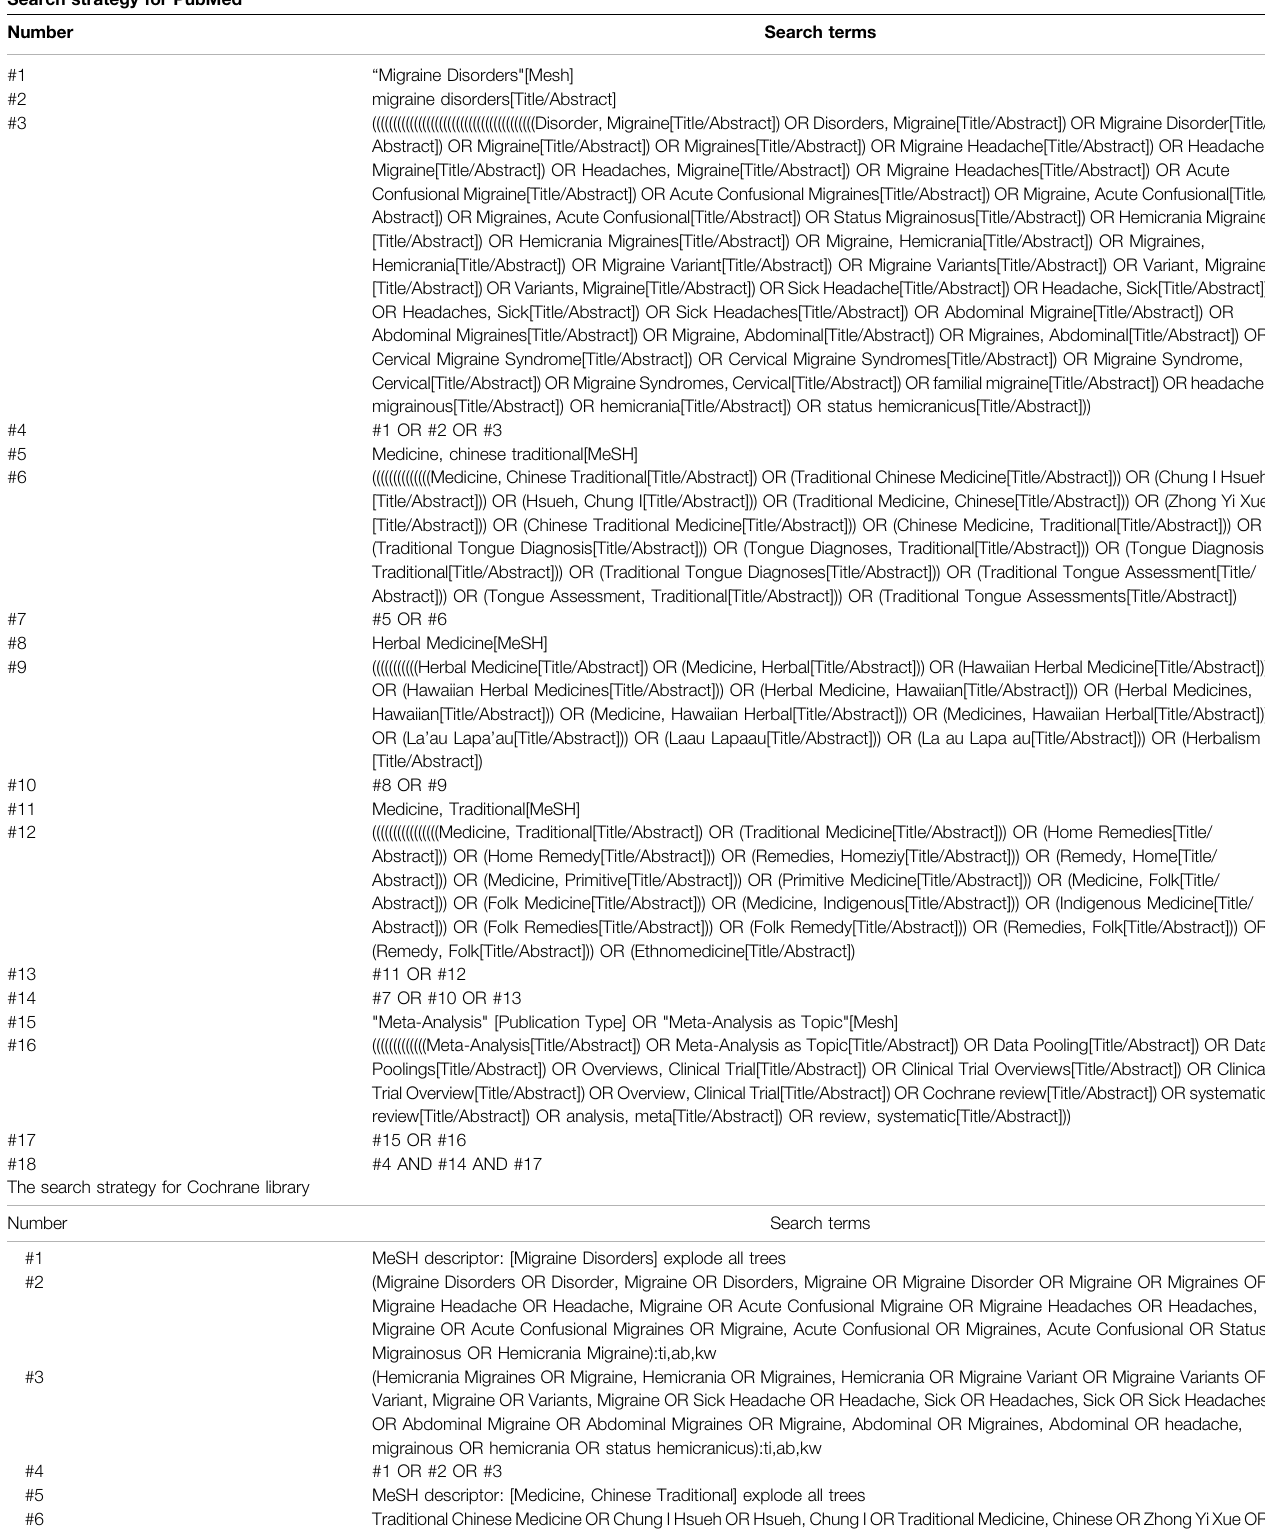
TABLE 1 | The search